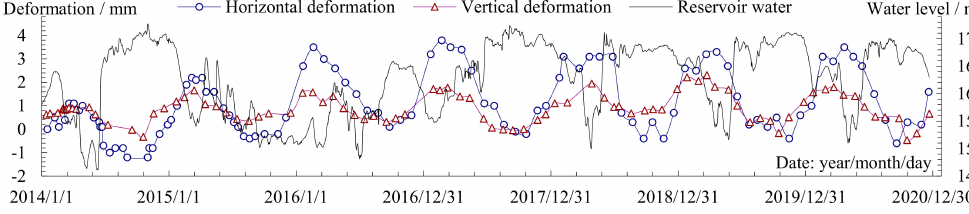
Figure 20. The measured values of the horizontal and vertical deformation at the dam crest. The relationships between the horizontal and the vertical displacement and the length of the interlayer joint were constructed through the polynomial regression, as shown in Figure 21. The deformation of the dam crest can be estimated from the length of the interlayer joint. When the length was 9 m, the interlayer crack extended to the curtain, at this time, the horizontal displacement was 8.3 mm and the vertical displacement was 1.29 mm. For RCC gravity dams, the further propagation of the cohesive cracks at the dam heel would damage the grouting curtain. Generally speaking, most of curtain centerlines were located at the distance from the upstream dam heel 0.06 H 0 –0.10 H 0 ( H 0 is the maximum water depth, calculated from the bedrock at the normal water level), or about 0.1 times the width of the dam bottom. Therefore, the center line of the curtain was 9 m from the dam heel in the RCC dam. When the crack depth in the dam heel reached 9.73 m, it had extended to the centerline of the curtain. In this case, the penetrated water in the joint would increase the uplift pressure on the foundation surface to weaken the dam stability, thus the remedial measures must be taken to prevent the RCC dam from losing its stability during long term operation.